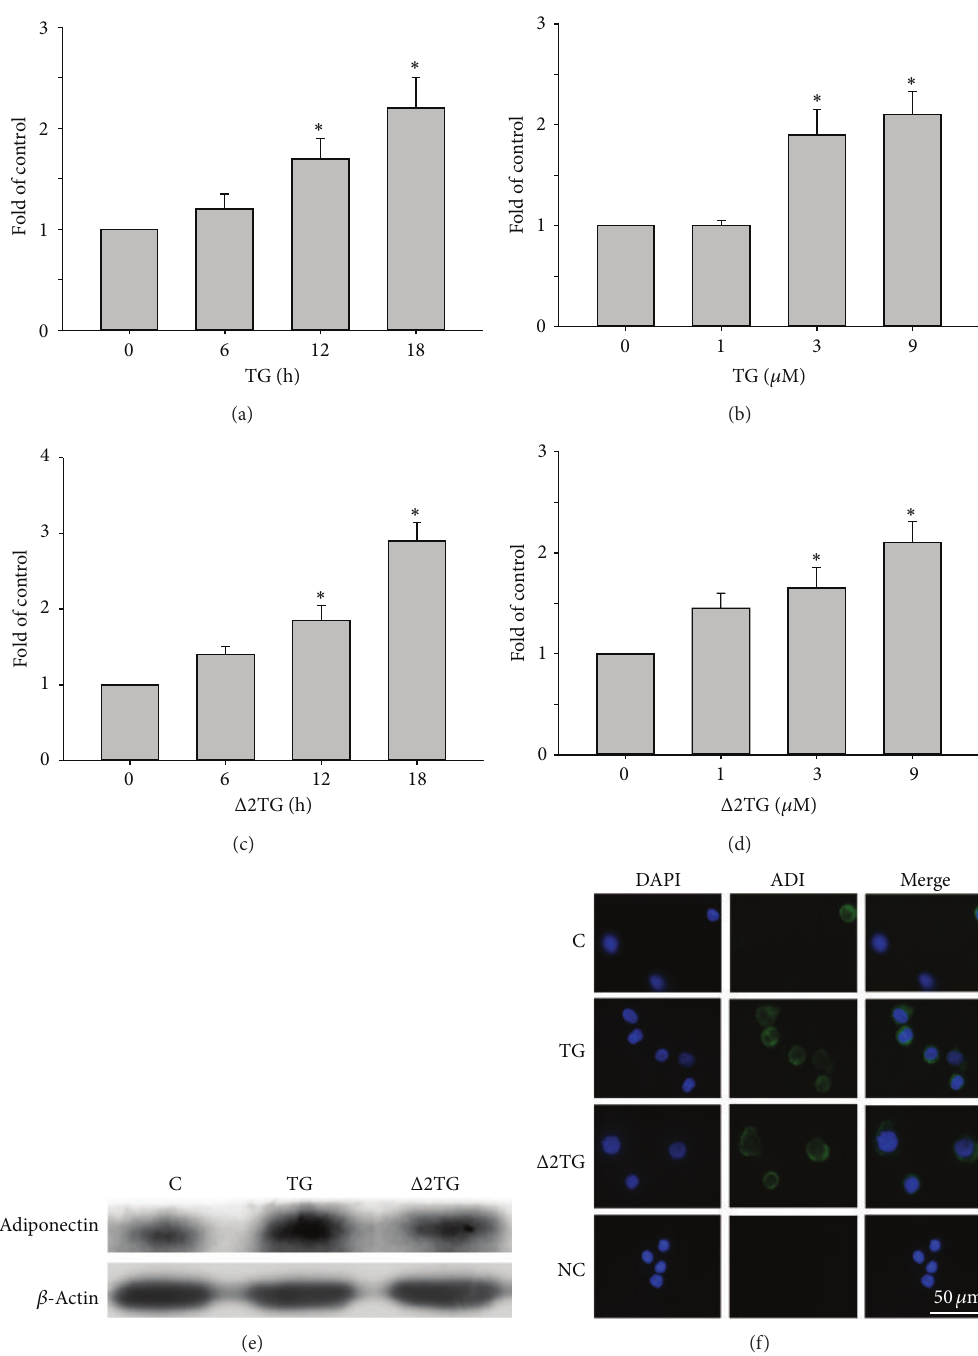
Figure 3: Troglitazone (TG) and Δ 2troglitazone ( Δ 2TG) enhanced adiponectin mRNA and protein expression in THP-1 cells. ((a)–(d)) The expression of adiponectin mRNA was examined by quantitative RT-PCR. Macrophages were treated with 9 𝜇 M of TG for the indicated time (a) or with the indicated concentration of TG for 18h (b). In addition, macrophages were treated with 9 𝜇 M of Δ 2TG for the indicated time (c) or with the indicated concentration of Δ 2TG for 18h (d). GAPDH was used as the internal control. (e) Macrophages were incubated for 18h with 9 𝜇 M of TG or Δ 2TG and adiponectin protein expression was measured in cell lysates by Western blotting. 𝛽 -actin was used as the loading control. (f) Macrophages were treated for 18 h with 9 𝜇 M TG or Δ 2TG, and then, the distribution of adiponectin was analyzed by immunofluorescentmicroscopy.ThemergedimagesofadiponectinstainingandDAPIwereshownontherightpanel.Adiponectinexpression is indicated by green fluorescence (FITC) and nuclei by blue fluorescence (DAPI). The level of adiponectin expression was higher in TG or Δ 2TG-treated cells. Scale bar = 50 𝜇 m. ∗ 𝑃 < 0.05 as compared to the untreated